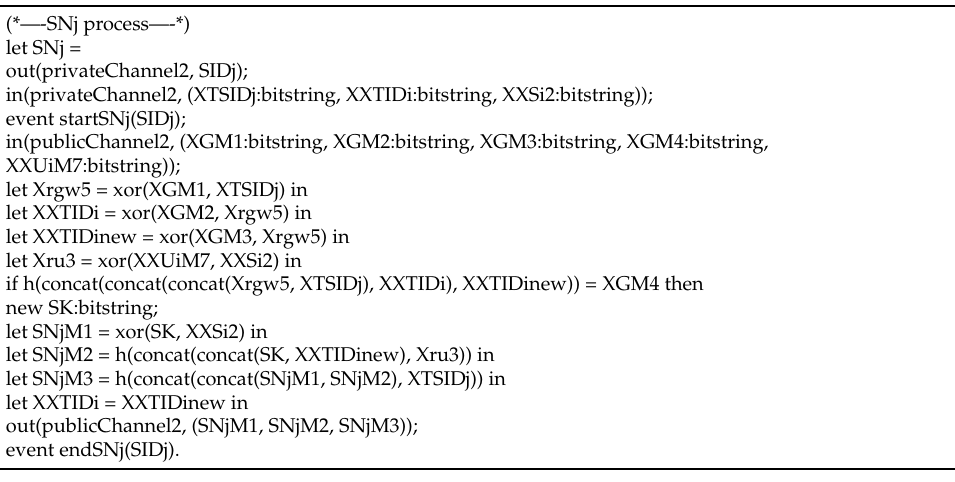
Table 8. Sensor node’s process.